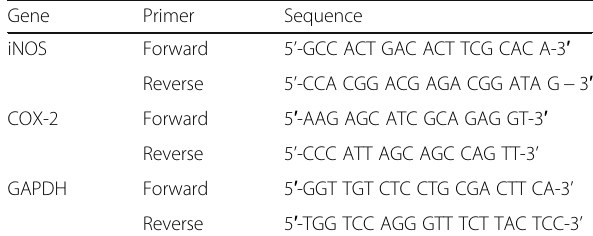
Table 1 Oligonucleotide sequence of quantitative real-time PCR